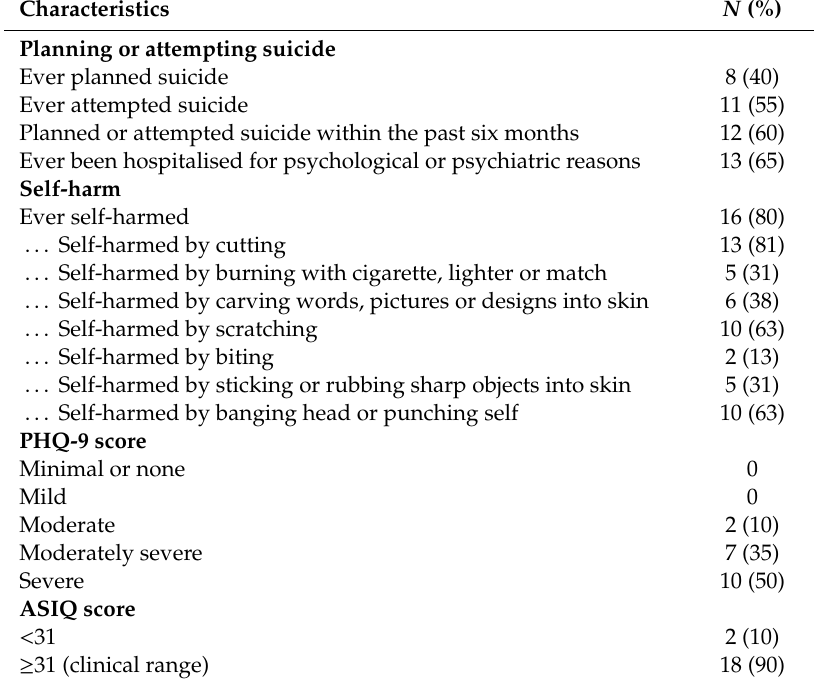
Table 2. Clinical characteristics of the sample at